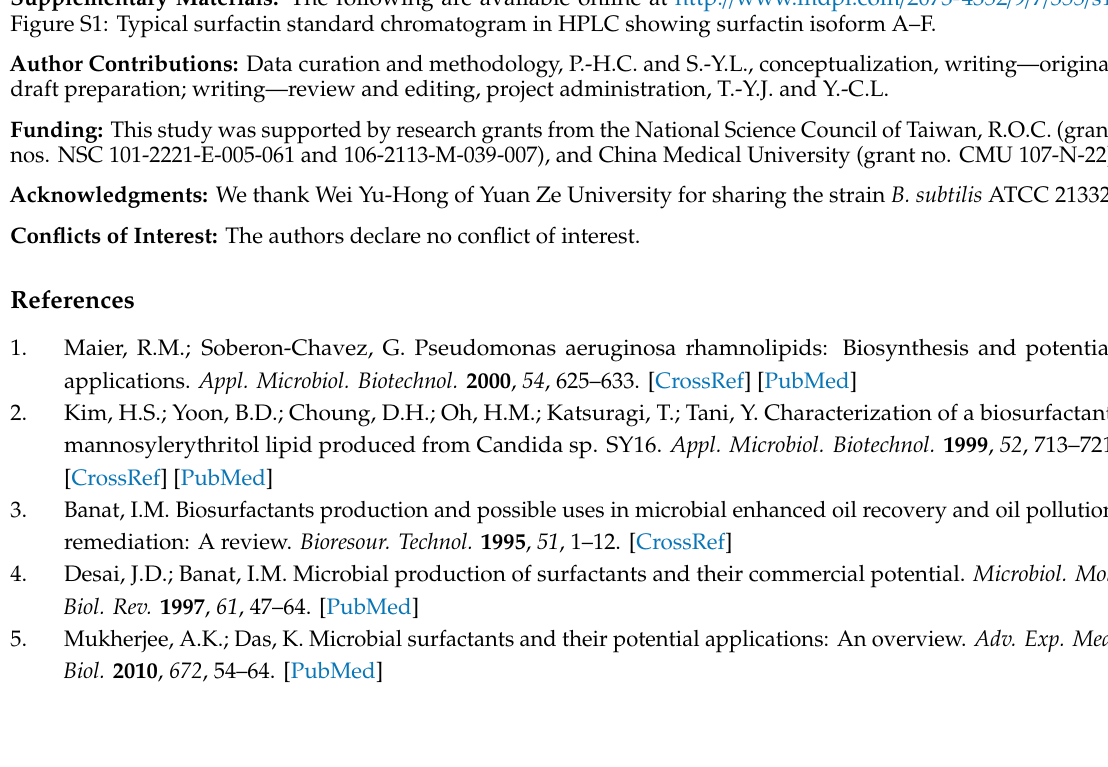
Figure S1: Typical surfactin standard chromatogram in HPLC showing surfactin isoform